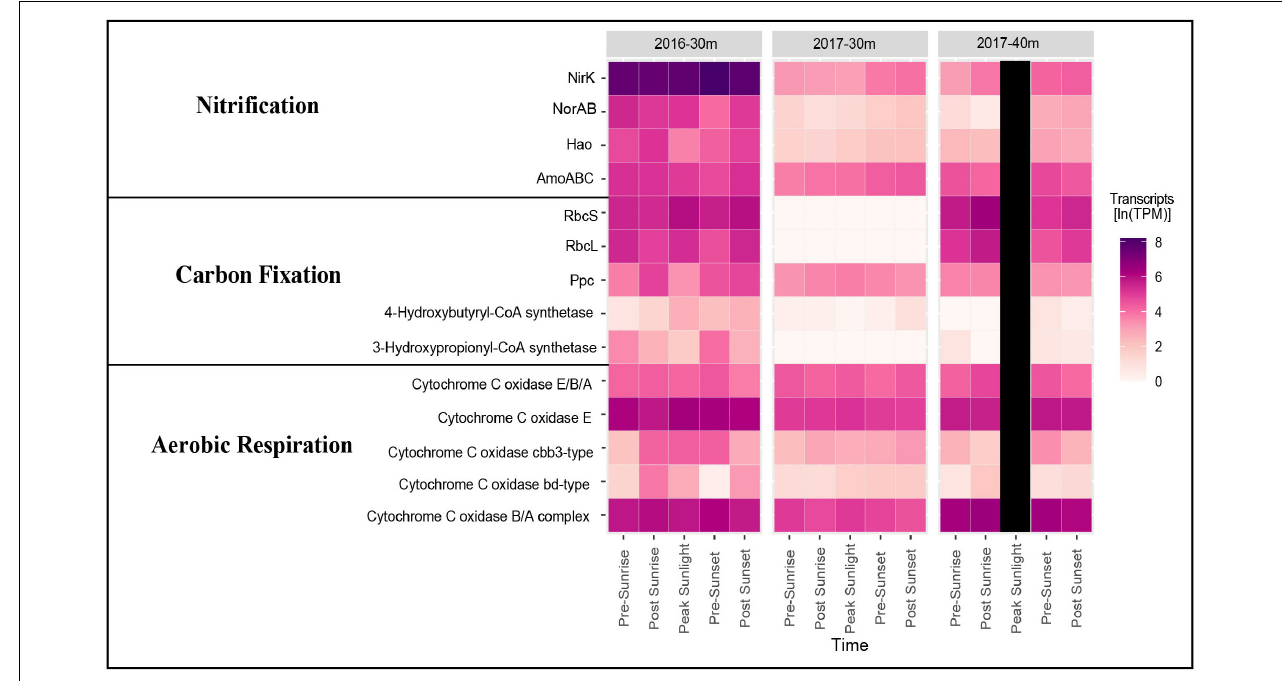
FIGURE 4 | Heatmap showing gene expression in ln(TPM) for genes associated with nitrification, carbon fixation, and aerobic respiration in the euphotic layers of each